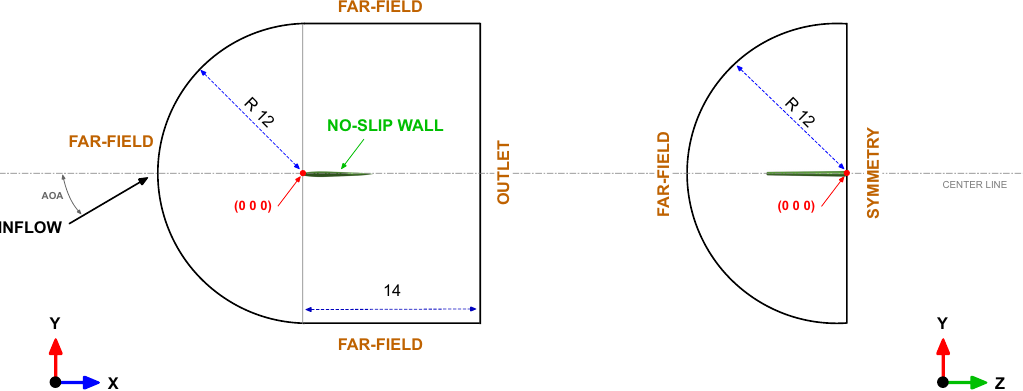
Figure 9. Computational domain and boundary conditions (all dimensions are in meters). The illustration is not to